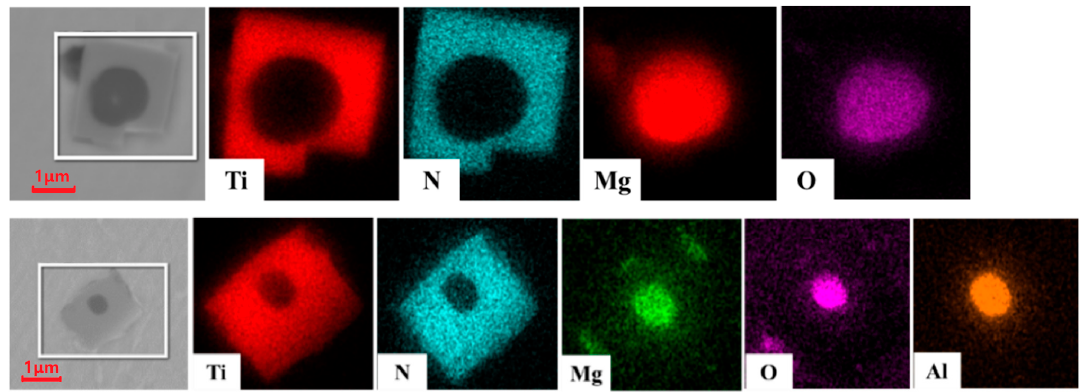
Figure 12. Appearance of TiN particles in specimens before magnesium treatment.